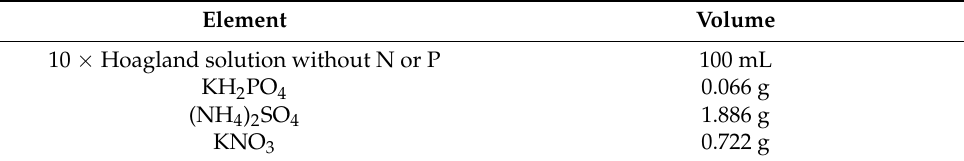
Figure 1. Seven common O. javanica cultivars tested in this study. Table 1. Formula of the simulated livestock wastewater (1 L).